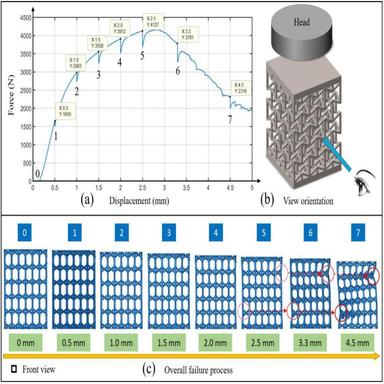
In-situ compression results: (a) the curve of force versus displacement; (b) view orientation; (c) the front view of CT reconstruction at different steps represents overall failure process of re-entrant lattice.